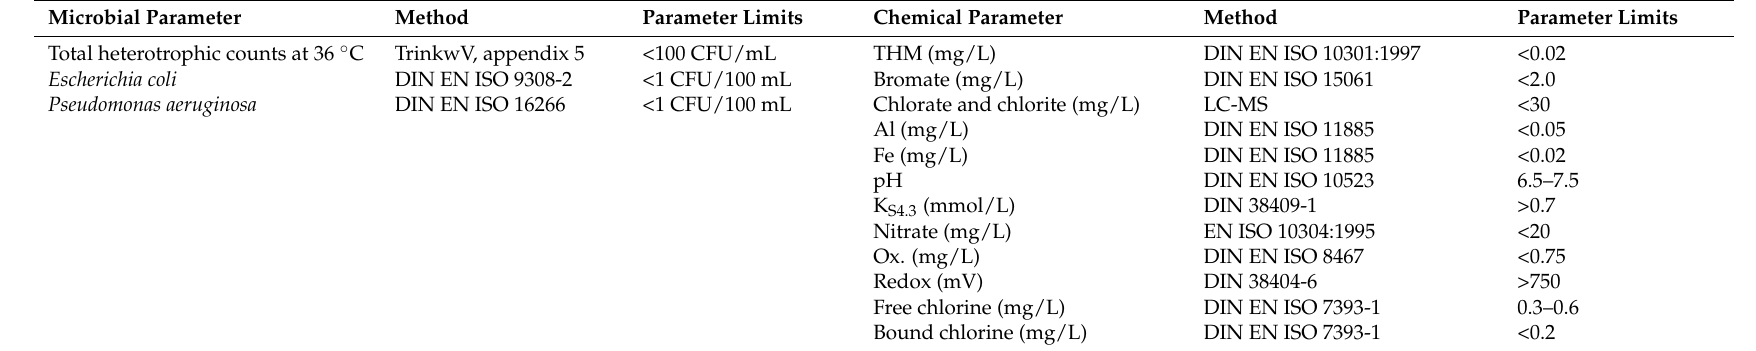
Table 2. Parameter limits are according to DIN 19643-1 [21]. Limits are only valid for pool water and filtrate (not for balance tank water and filter backwash water). Microbial